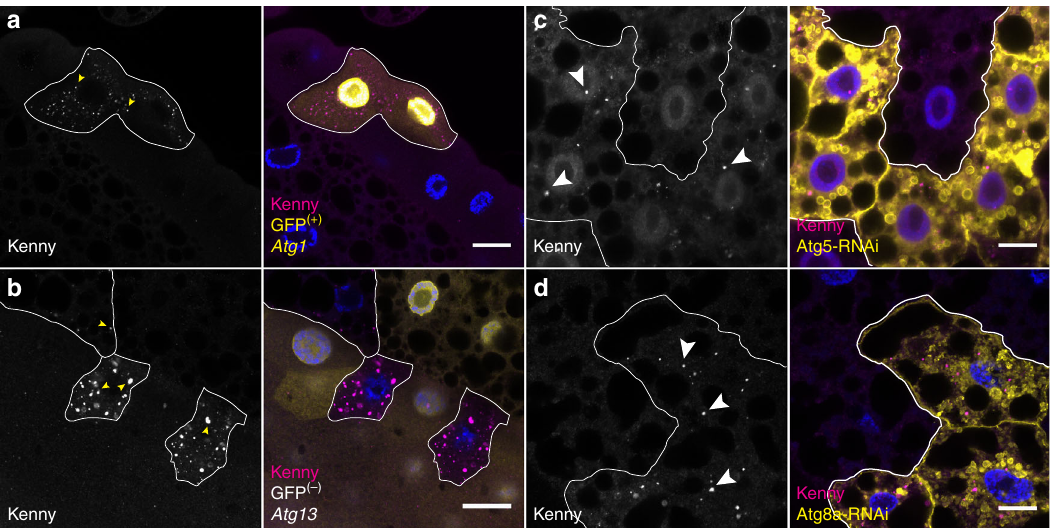
Fig. 4 Kenny protein accumulates in cells lacking different components of the core autophagy machinery. Confocal images from fat body or salivary glands clonally lacking the expression of key components of the core autophagy machinery, and stained for endogenous Kenny (magenta) protein and Hoechst (blue). a Atg1 null mutant cells expressing nuclear GFP (yellow) were generated by MARCM. b Atg13 null mutant cells, lacking the expression of nuclear GFP (yellow), were generated by FRT/FLP recombination. c , d RNAi silencing of Atg5 c and Atg8a d in cells expressing mCD8-GFP (yellow) were performed using the FLPout system. Arrowheads show some Kenny aggregates. Scale bars are 20 µ